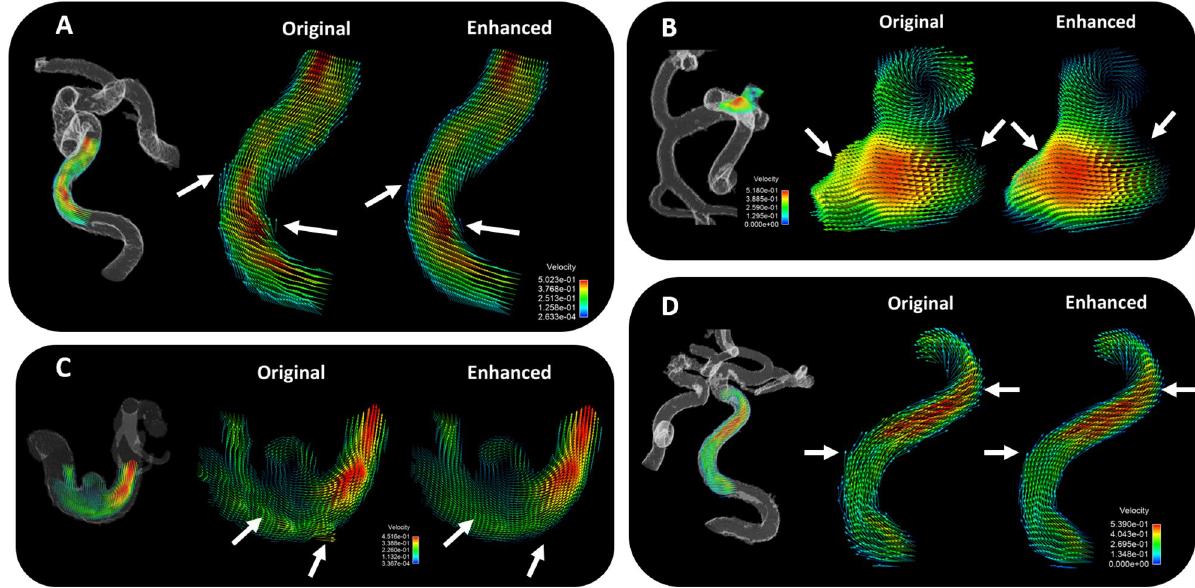
Figure 6. Velocity vectors in select planes of patient cerebrovascular anatomy. ( A ) Near wall vector alignment and velocity gradients are improved with ML enhancement, as displayed on a transverse plane through an internal carotid artery (ICA) ( B ) Smoother velocity gradient transitions in are observed in the ML enhanced data of a cerebral aneurysm and its surrounding vasculature structure ( C ) Unrealistic velocity fluctuations are removed during ML enhancement, as observed in the parent vessel surrounding a cerebral aneurysm ( D ) Near wall velocity characterization is cleaned in a tortuous ICA segment, which had a large impact on quantification of near-wall flow metrics, such as wall shear stress.